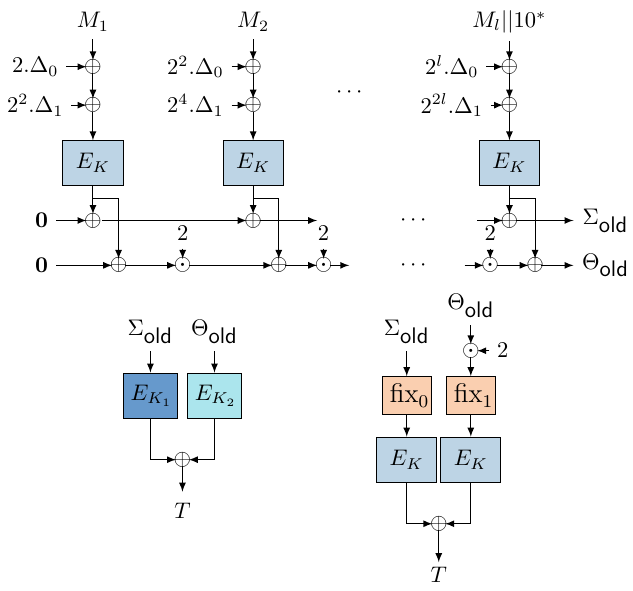
Figure 1.2: (i) Upper construction combined with the lower left construction is PMAC_Plus